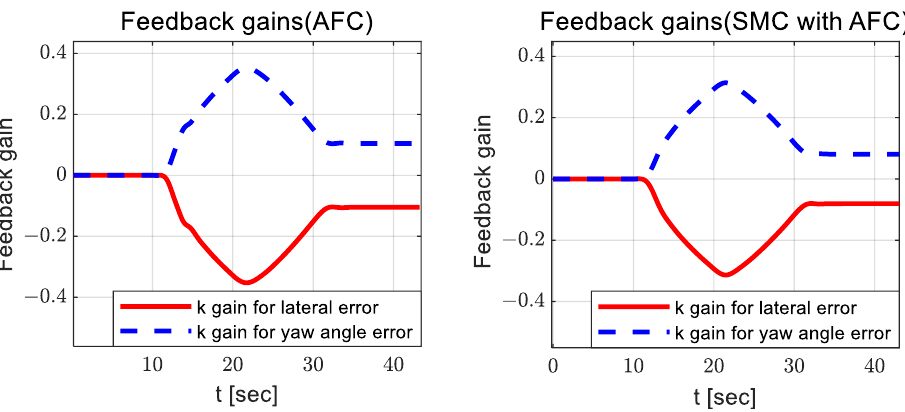
Figure 8. Results: adapted feedback gains (AFC — left ; SMC with AFC — right ) for the curved path tracking.